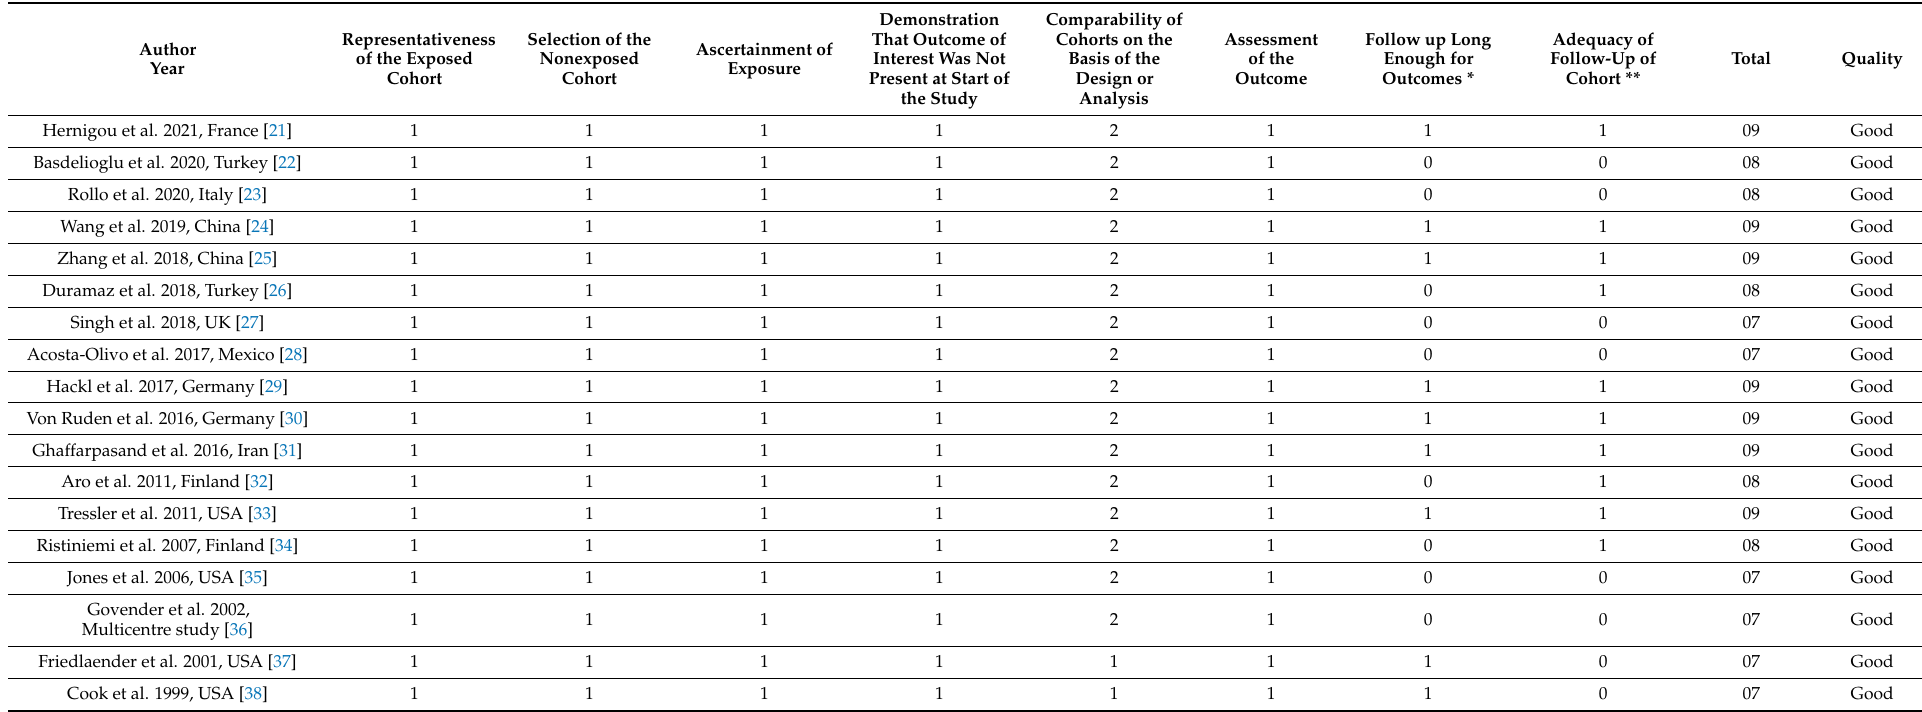
Table 3. Study quality of the included studies based on the Newcastle–Ottawa scale (* Follow-up more than 24 months; ** Lost to follow-up rate more than 10% is considered